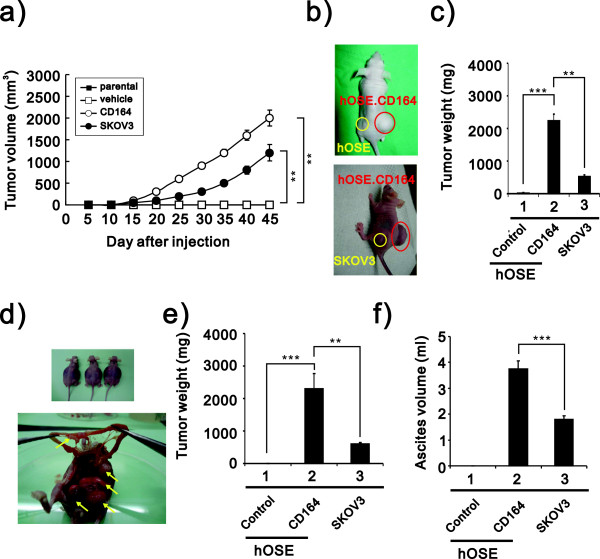
CD164 overexpression promotes tumor formation in nude mice. a) The tumor growth of hOSE-CD164 cells, control cells and SKOV3 cells subcutaneously injected into female athymic nude mice (n = 8, each group) was assessed every 5 days for 45 days by measuring two perpendicular diameters and calculating the tumor volume in mm3. Tumor size was measured during 7–8 weeks and calculated as follows: volume = length × width2 × 1/2. ** p < 0.01. Data represent the means ± SEM. b) Macroscopic appearance of hOSE-CD164 (top and bottom, red), hOSE control (top, yellow) and SKOV3 (bottom, yellow) tumors formed subcutaneous tumors. c) Quantification of the tumor weight of hOSE-vector and hOSE-CD164 cells (4 × 106) after subcutaneous injection in the flanks of nude mice (n = 8, each group). Tumor weight was measured in the hOSE-CD164 cells and compared with hOSE-vector cells (*** p < 0.001) and SKOV3 (** p < 0.01) nude mice. d) Macroscopic appearance of hOSE-CD164 tumors (upper) spread and disseminated in the peritoneal cavity (bottom, arrows). e) hOSE-CD164 cells, control cells and SKOV3 cells (4 × 106) were injected into the peritoneal cavity of nude mice. Tumor weight was measured in the hOSE-CD164 cells and compared with hOSE-vector cells (*** p < 0.001) or SKOV3 (** p < 0.01) nude mice. f) At autopsy, tumors were excised and ascite fluid was collected and measured. *** p < 0.001.